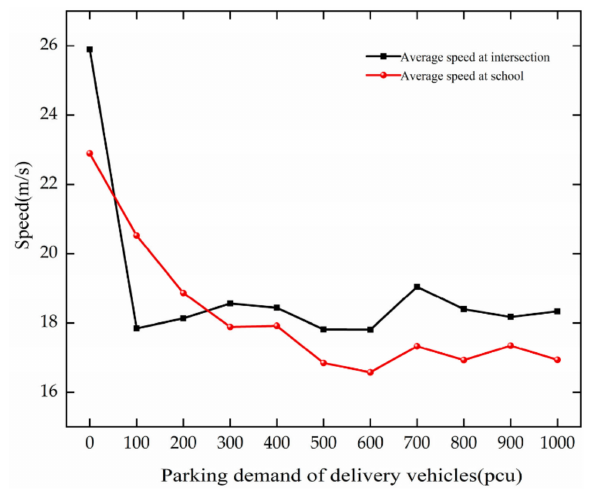
Figure 14. Variation trend of average speed with PDD.